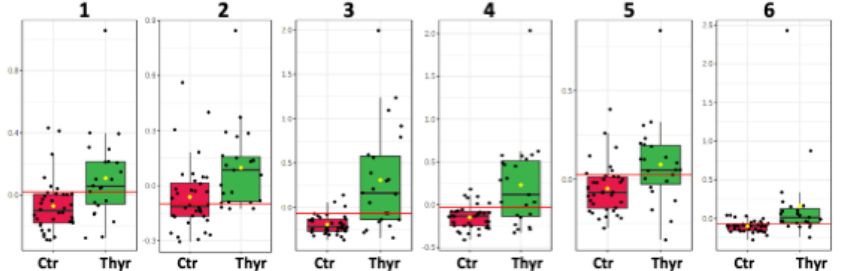
Figure 4. Box plots of the discriminant metabolites in colostrum. (1. Glycero-phosphocholine, 2. o-phosphocholine, 3. Fucosyl moieties, 4. Lactate, 5. Choline, 6. Threonine).